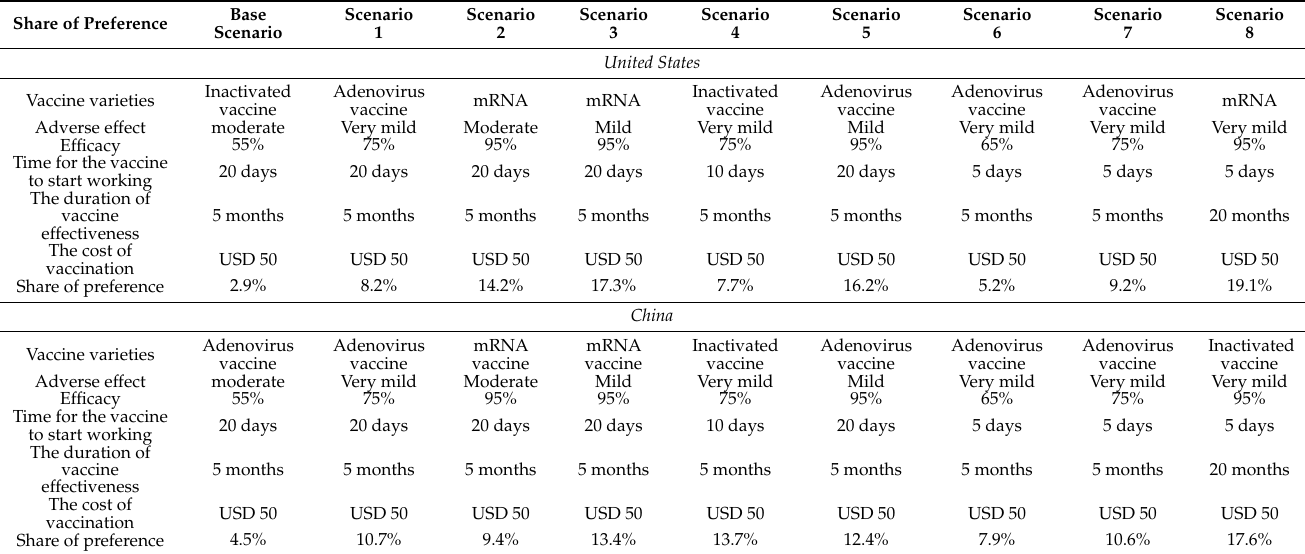
Table 2. Share of preference and scenario analysis